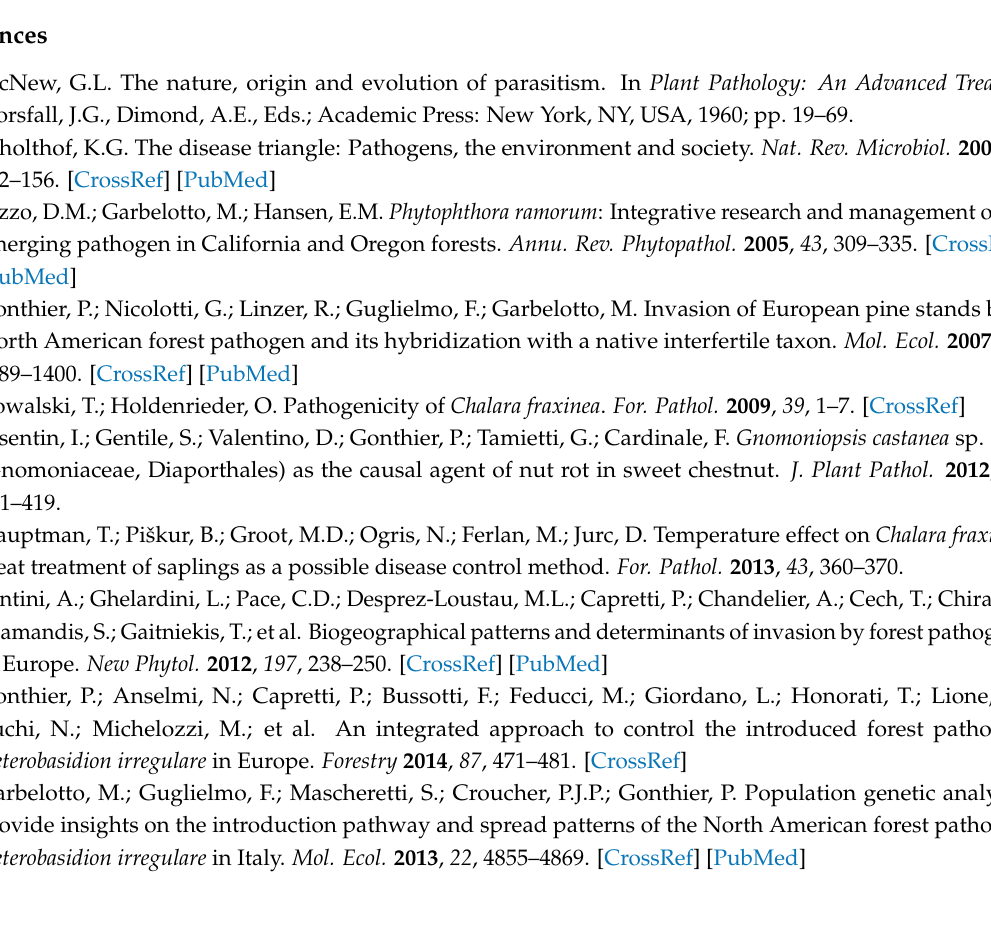
Figure S1: Scatterplot of the values of ϑ and ε resulting from the Monte Carlo experiment assessing ϑ = f ( ε ) , Figure S2: Azimuth distributions extracted from the associated raster, Table S1: Binary logistic regressions modelling the probability of recovery among trees whose infection status to P. ramorum was positive at least once, Algorithm S1: R-script for function LAMBDA , Algorithm S2: R-script for function PHI , Dataset S1: Point location estimates collected with a GPS device to assess of the goodness-of-fit of the Rayleigh distribution to the GPS radial error, Dataset S2: Seed values associated with the R-functions LAMBDA and PHI to allow the reproducibility of the process leading to the identification of trees recovered from P. ramorum infections, Dataset S3: Database with 8 field and 19,212 records resulting from the screening of the original “SODmap” database, Dataset S4: Overall dataset merging individual host species final datasets for scenario-10m, resulting from the application of the classifier Φ Λ integrated in the R-functions LAMBDA and PHI , Dataset S5: Overall dataset merging individual host species final datasets for scenario-500 m, Note S1: Assessment of the relation between GPS median error and spatial resolution of the grid-system, Note S2: Technical details about the classification algorithm, Note